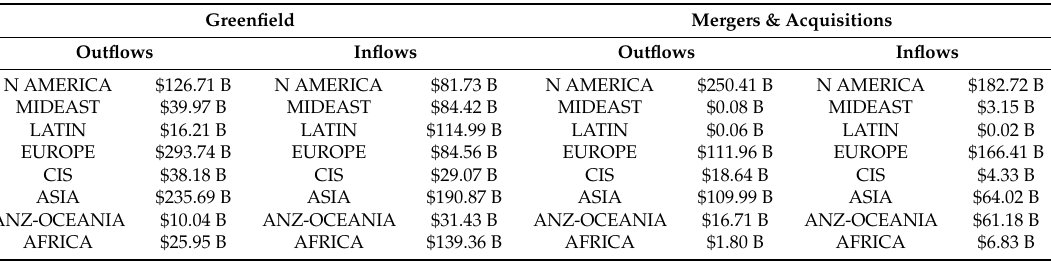
Table 2. M&A and GF FDI by region for energy investments.